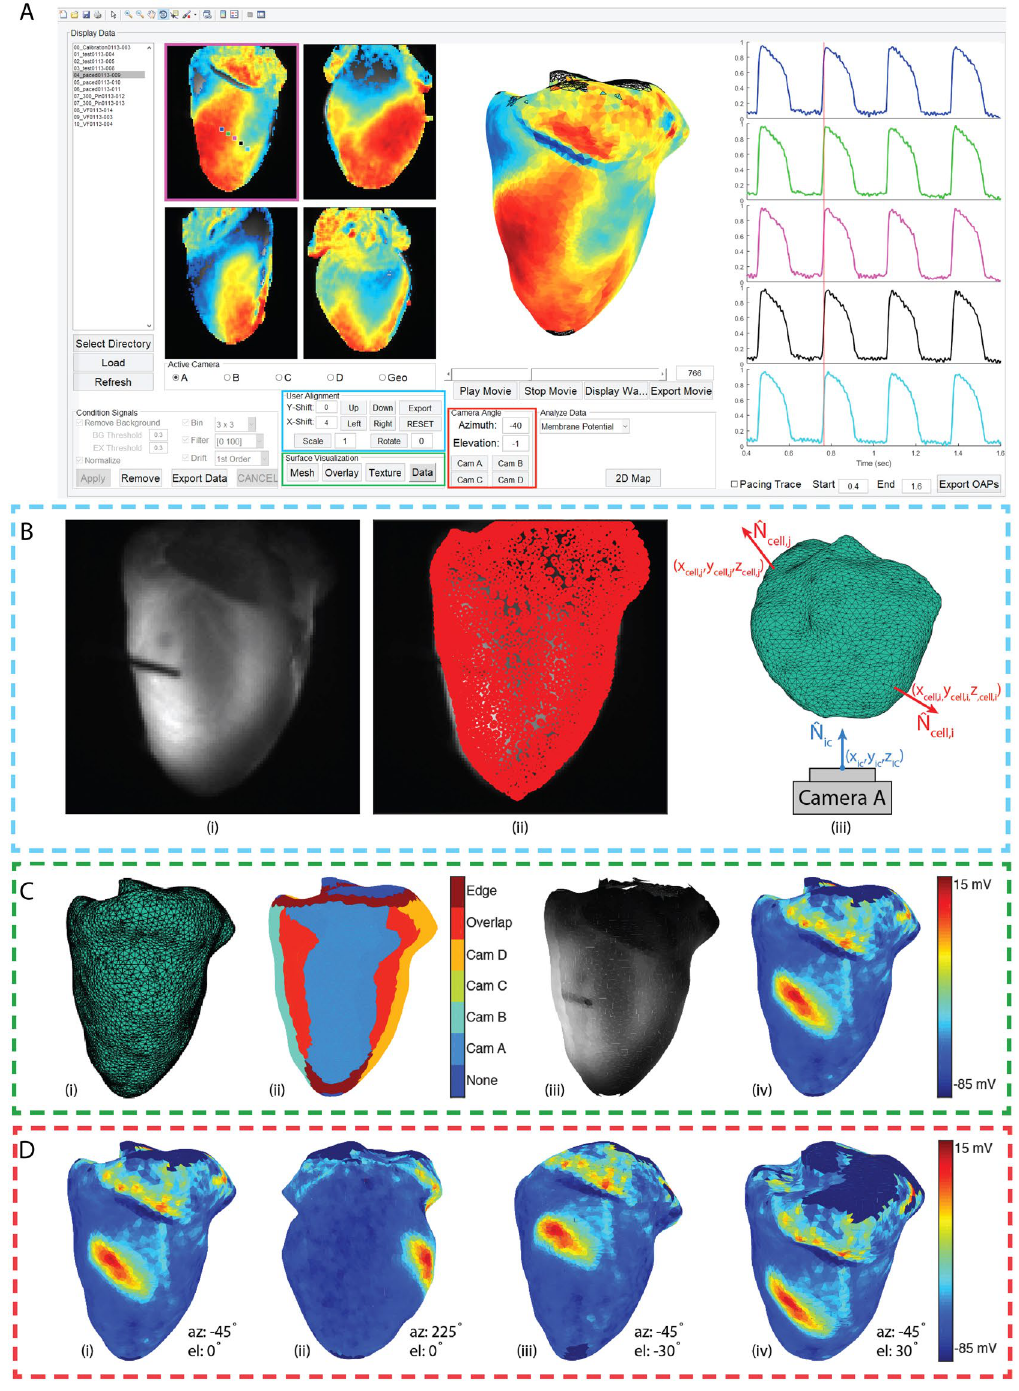
Figure 4. Data processing and projection ( A ) A final MATLAB graphical user interface was created to facilitate the processing of optical data and its projection onto the representative geometry. ( B ) Projection is accomplished by projecting the face centroids of the triangulated mesh onto the optical mapping cameras. Tools are provided to correct minor inaccuracies in projection. Camera facing centroids are first identified as those whose normals ( N cell ) creates an angle greater than 90° with the camera normal ( N ic ). ( C ) The surface can then be visualized as a triangulated mesh (i), a map of the camera assignments made to each centroid (ii), texture (iii), and membrane potential (iv). ( D ) Once correspondence has been established the geometry will appear with membrane potential mapped to the surface. Tools are provided to rotate the heart using click-and-drag, to the view from each camera, and to specific viewing angles using azimuth and elevation